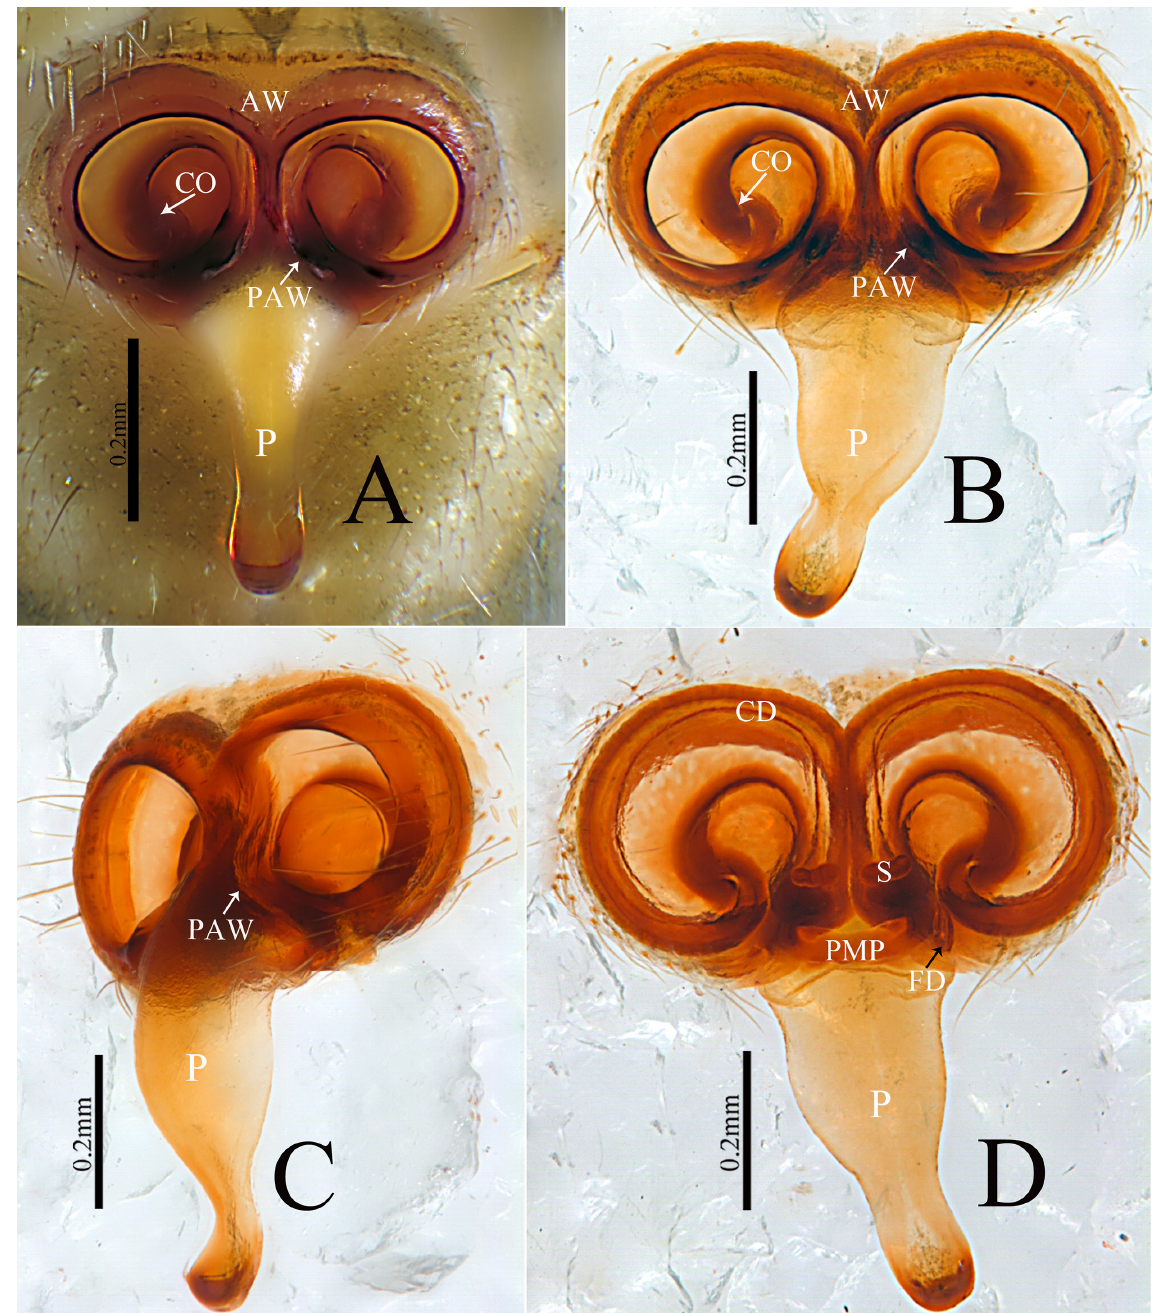
Fig. 17. Acroterius circinatus gen. et sp. nov., ♀, paratype (HNU-CGY137). A–B . Epigyne, ventral view. C . Epigyne, lateral view. D . Vulva,